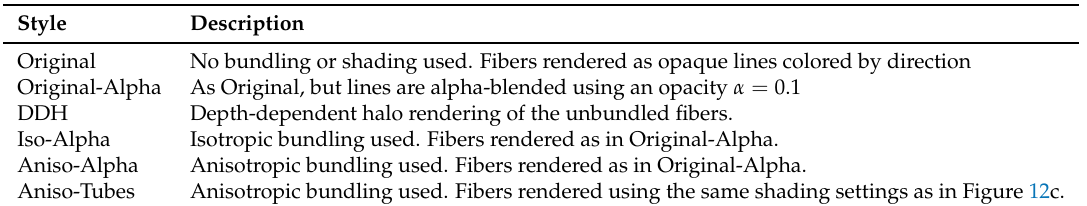
Table 4. Six bundling-and-rendering visualization styles used in the external evaluation. See Section